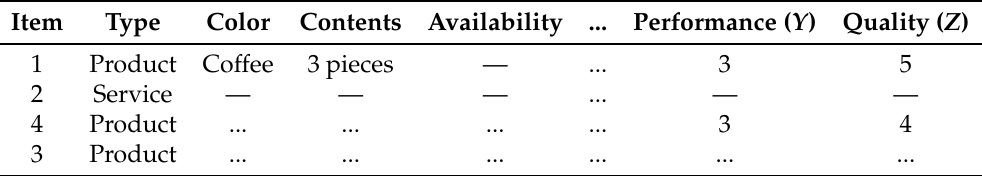
Table 4. A hypothetical example of the context element